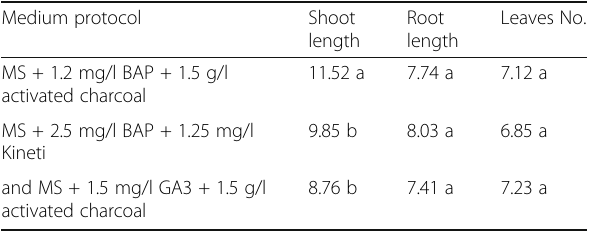
Table 1 Means of shoot, root length (cm), and leaves number, as influenced by media protocols of buds Medium